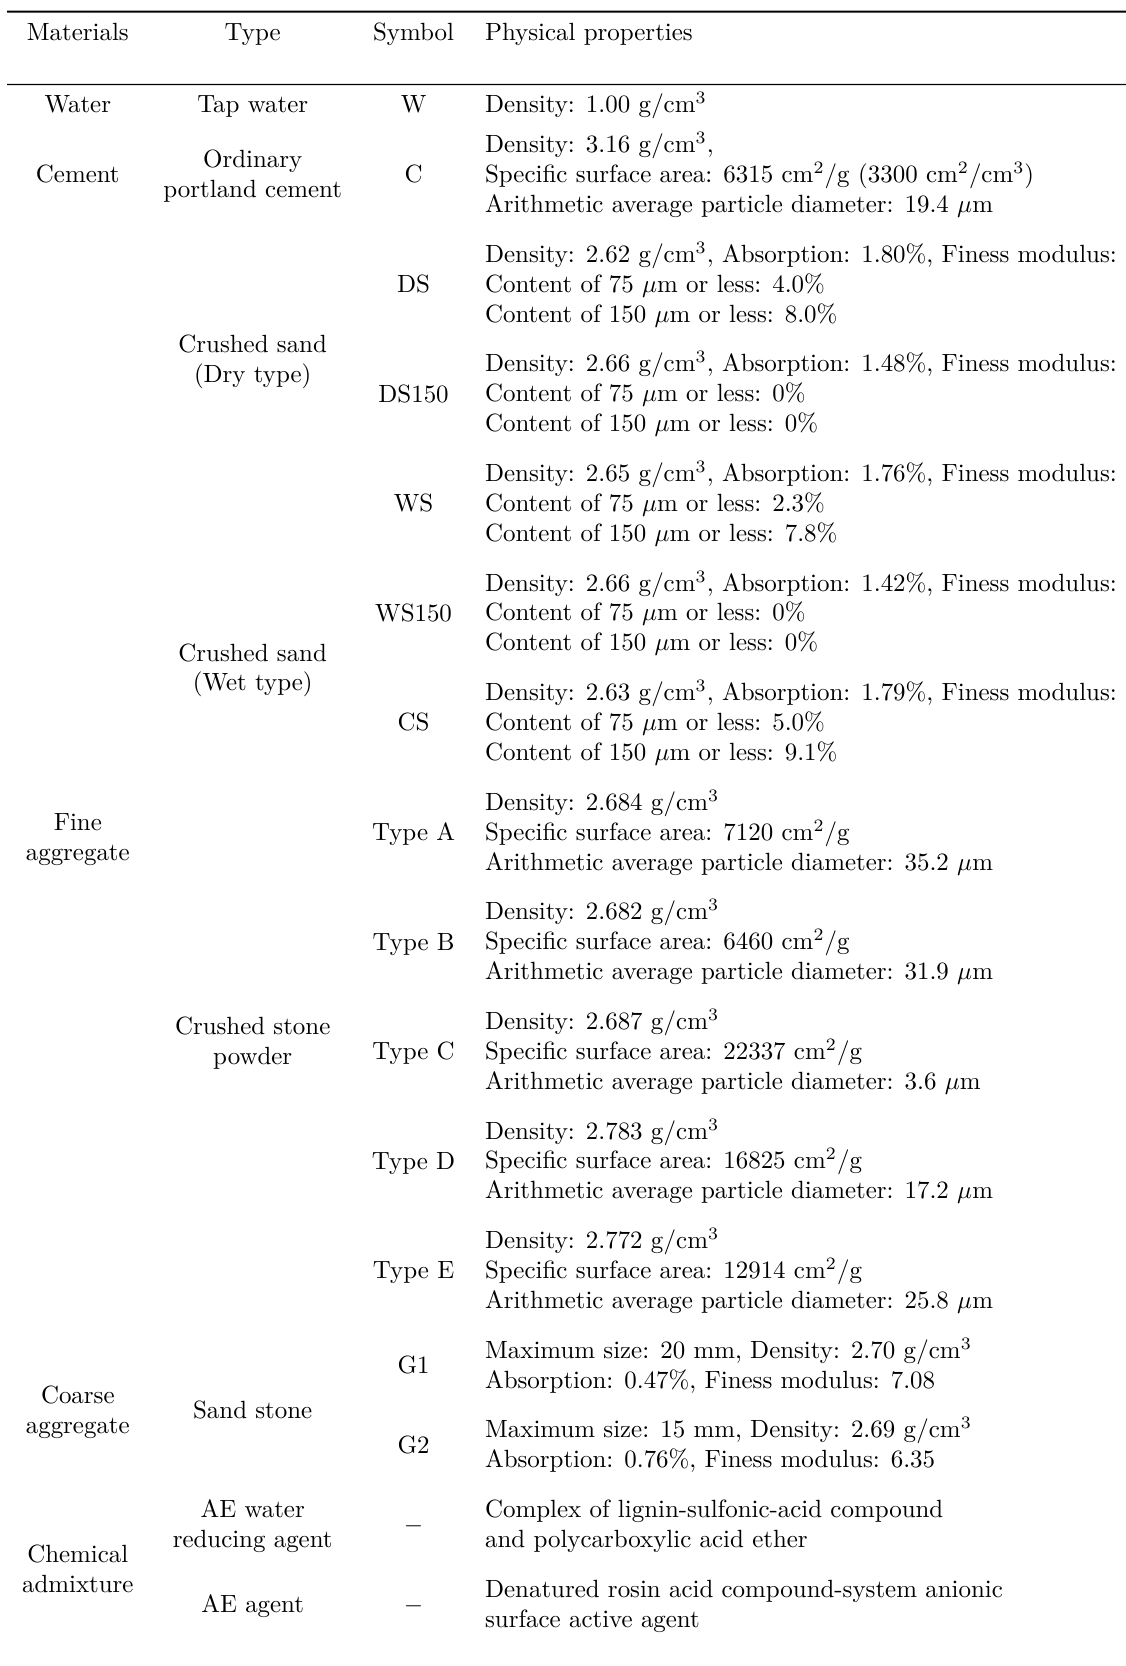
Table 1. Constituent materials of